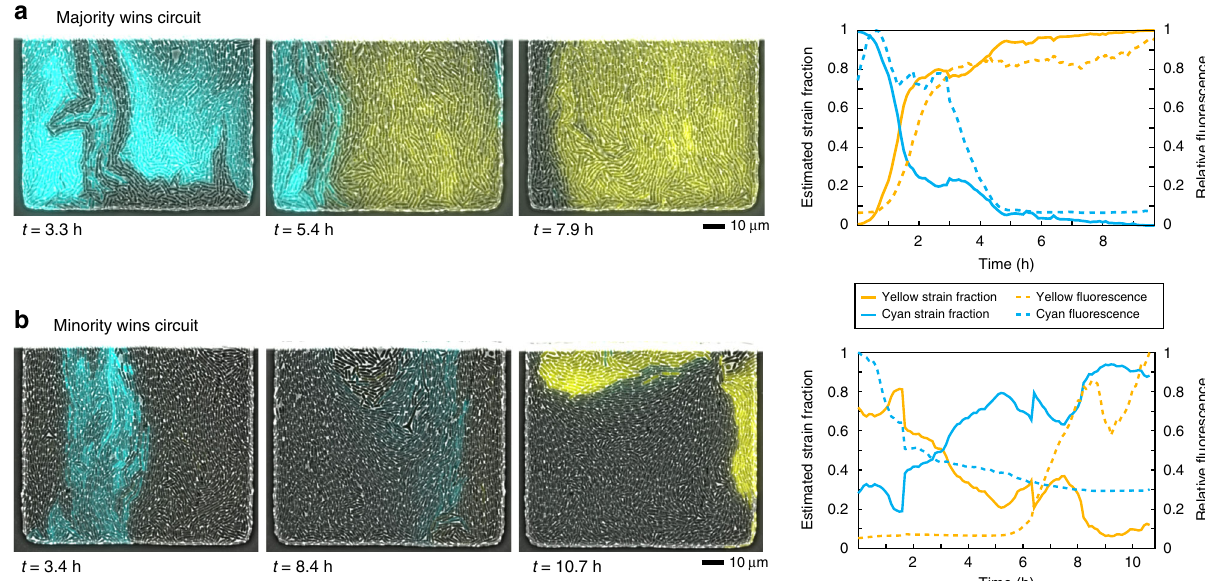
Fig. 6 Majority and minority wins consortia in fl uctuating environment. a Response of majority wins consortium to strain ratio fl uctuations in a micro fl uidic device over time. As the cyan strain went from the major fraction to the minor fraction of the population, the fl uorescent state of the system switched from cyan strain ON to yellow strain ON, displaying a majority wins pattern as strain ratios fl uctuate. To the right is a quanti fi cation of the fl uorescence compared to estimated strain ratios over time. Video for this experiment is provided in the supplement as Supplementary Video 1 (Majority Wins1). b Response of minority wins consortium to strain ratio fl uctuations in micro fl uidic device over time. As the cyan strain went from the minor fraction to the major fraction of the population, the fl uorescent state of the system switched from cyan ON to yellow ON, displaying a minority wins pattern as strain ratios fl uctuate. To the right is a quanti fi cation of the fl uorescence compared to estimated strain ratios over time. Video for this experiment is provided in the supplement as Supplementary Video 2 (Minority